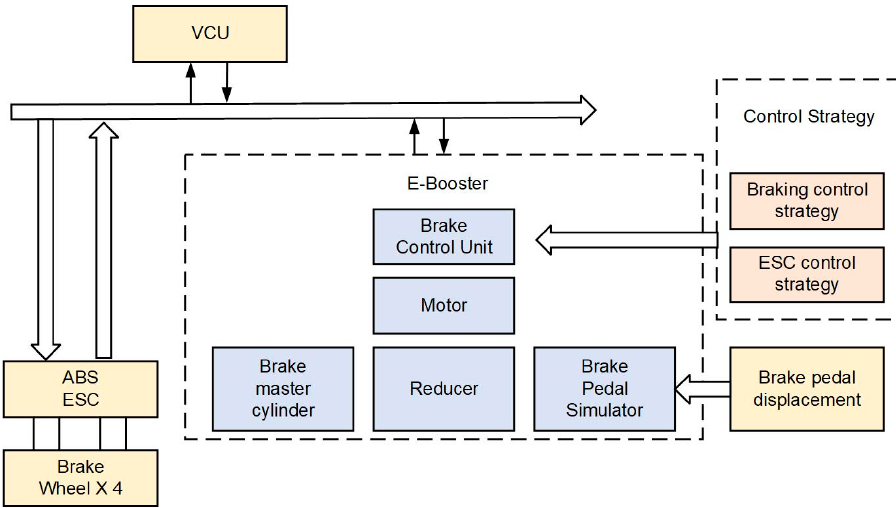
Figure 2. The composition of EHB system.